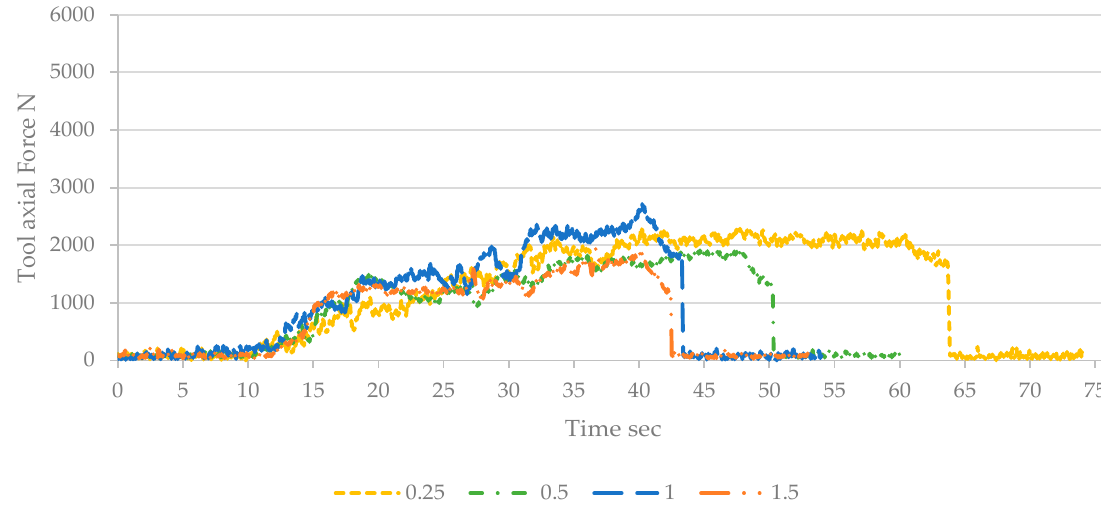
Figure 8. Effect of changing the feed rate during the weld stroke on welding force from R DWP = 0.25 to 1.5.